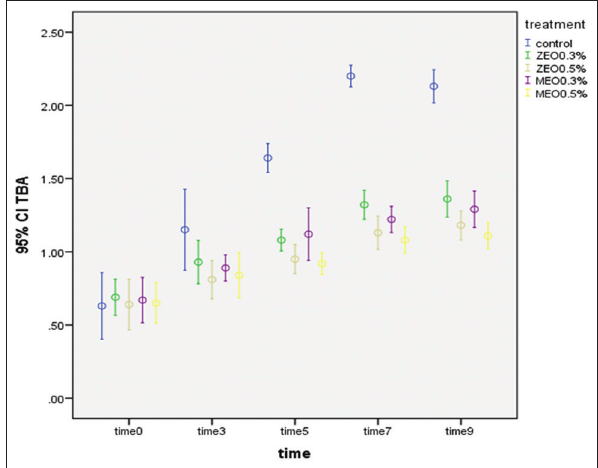
Figure-1: Thiobarbituric acid values of minced beef containing different levels of Zataria multiflora and Mentha piperita essential oils during 9 days of storage at